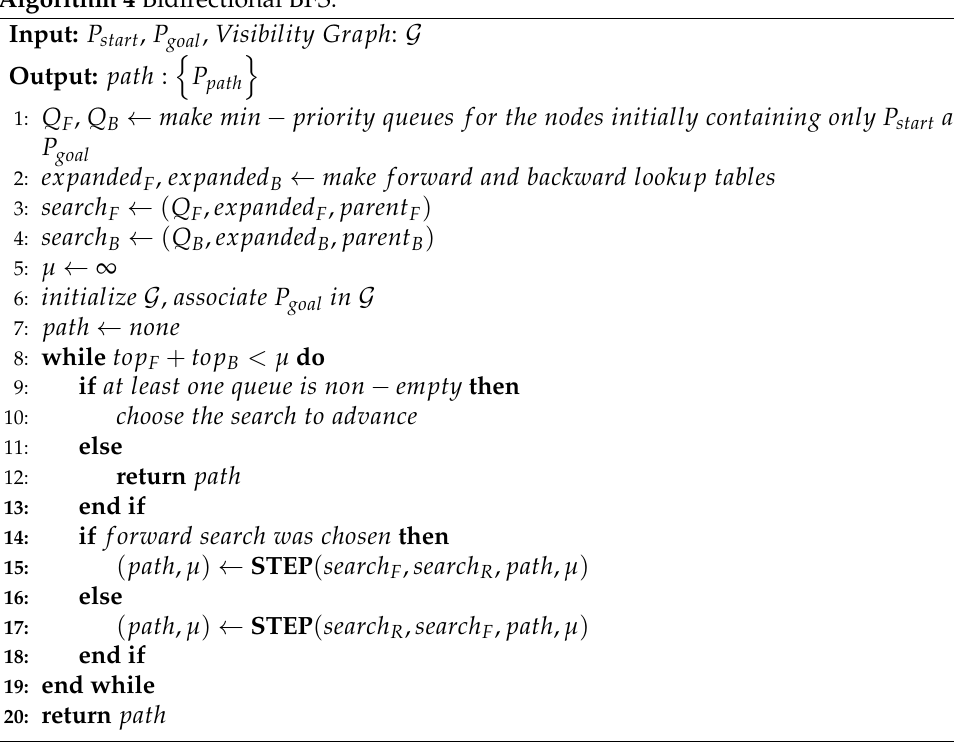
Algorithm 4 Bidirectional BFS.